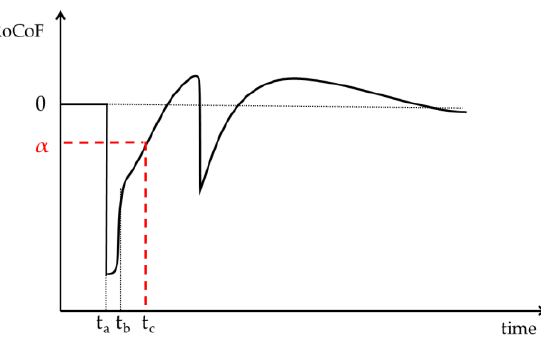
Figure 6. RoCoF and RoCoF constant α.